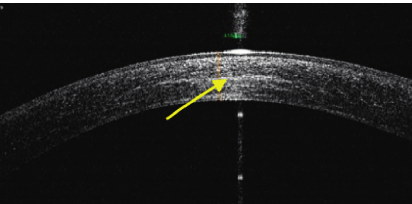
Figure 4: Anterior segment OCTimage of the cornea showing demarcation line in post-CXL eye at 24-month follow-up at depth of 265 μ